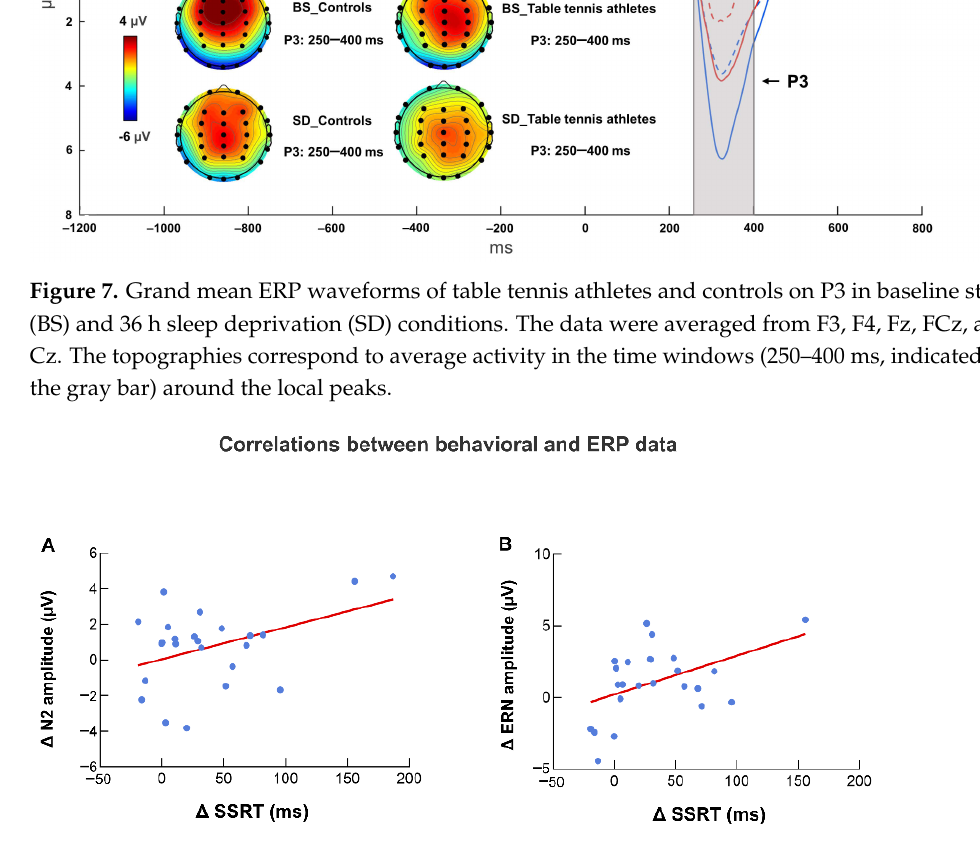
Figure 8. Correlations between behavioral and ERP data. ( A ) Correlation between ∆ N2 amplitude (SD-BS) and ∆ SSRT (SD-BS). ( B ) Correlation between ∆ ERN amplitude (SD-BS) and ∆ SSRT (SD -BS).